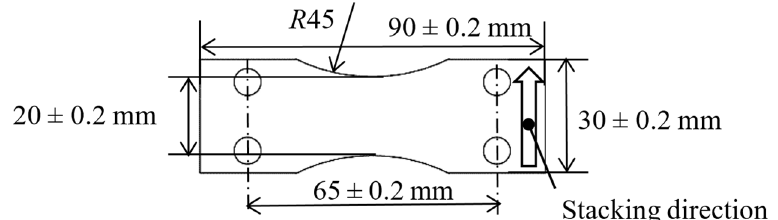
Figure 1. Geometry of the fatigue specimen for the displacement-controlled plane bending fatigue test. The thickness was 2.6 ± 0.2 mm for the direct metal laser sintering (DMLS) specimen and 2.0 ± 0.2 mm for the electron beam melting (EBM) specimen.